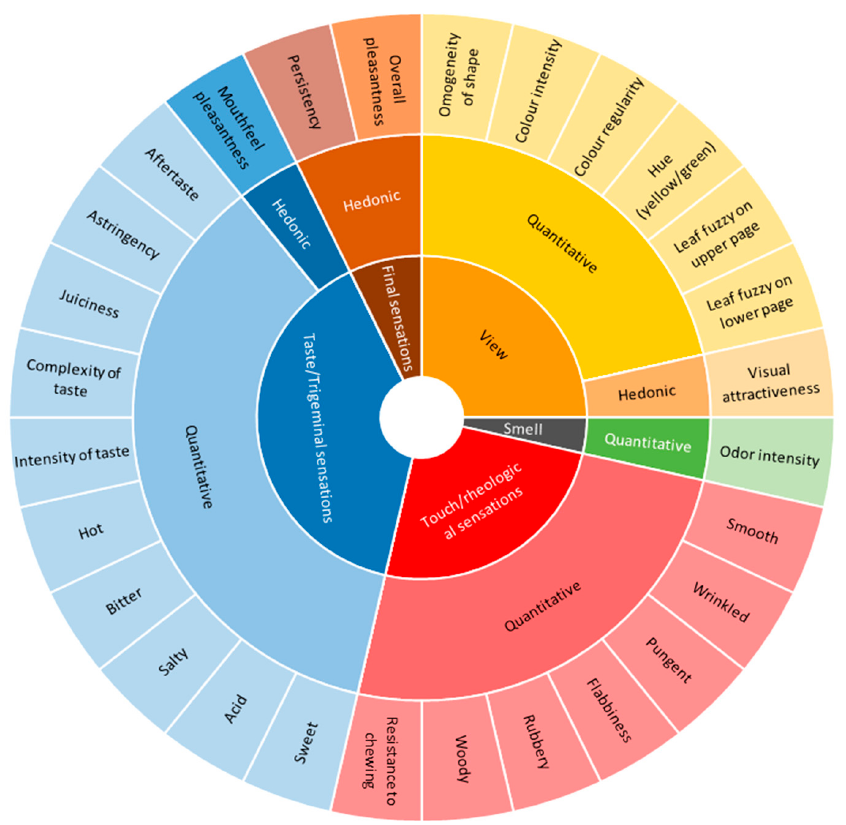
Figure 1. Sensory wheel specifically developed to separately describe each wild-collected and domesticated species using three different methods: “soilless”, pot, and open field. The panelists always had the option to include relevant specific observations for each analysed herb in the “others” parameter.